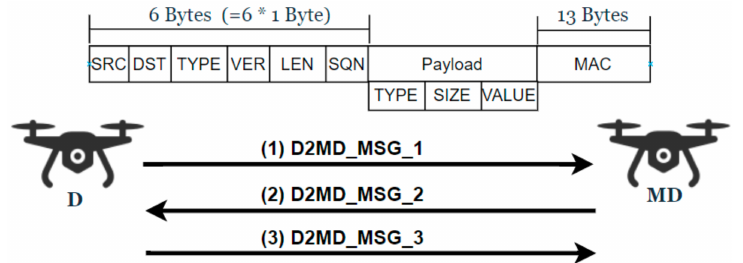
Figure 4. D2MD communication and packet structure.